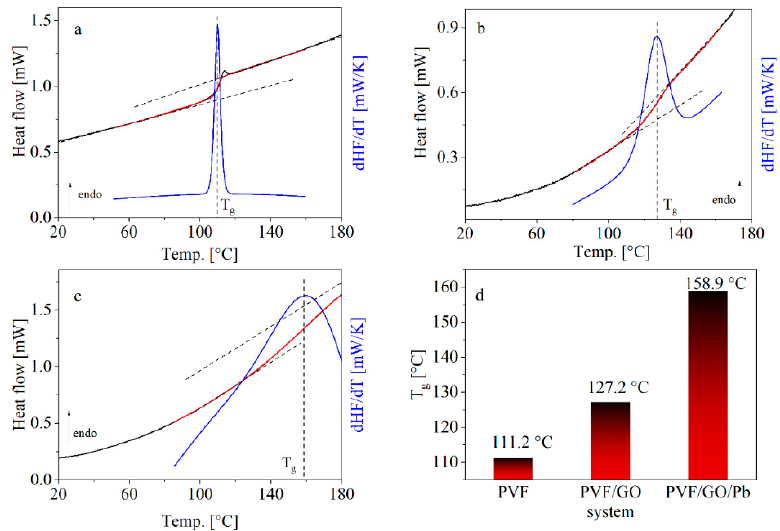
Figure 7. DSC thermograms of pure PVF ( a ), PVF/GO ( b ) and the PVF/GO/Pb composite ( c ) during the 2nd heating run (10 K/min). The red curve is a sigmoidal fit to the data. The blue curve is the first derivative of the sigmoidal curve with respect to temperature. The maximum of the peak corresponds to the glass transition temperature. The T g values obtained for the different systems are given in part ( d ).